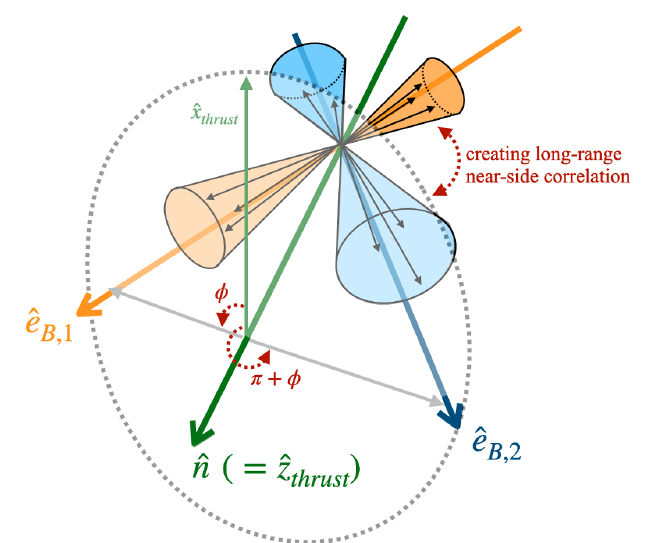
Figure 14. A schematic diagram indicating how a special arrangement of two B decay system can have a long-range near-side correlation. The orange cones represent the decay products from one of the B mesons, and the blue cones are from the other B decay. Two B decay directions are expressed with notations ˆ e , ˆ e . The event thrust direction ˆ n is prone to lie on the plane spanned by ˆ e B, 1 B, 2 ˆ e , hence dividing the decay products into two parts, aggregating at azimuthal coordinates around B, 2 φ or π + φ , respectively. In this configuration, the decay products from the opposite B mesons (the orange and blue cones) easily contribute to the long-range near-side